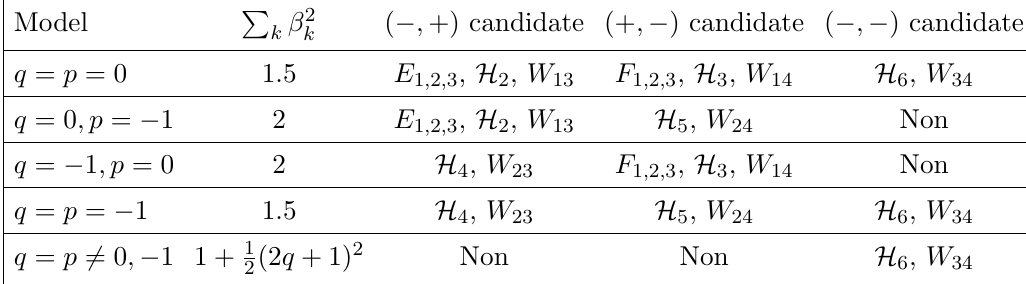
Table 4 . Schemes of two-component dark